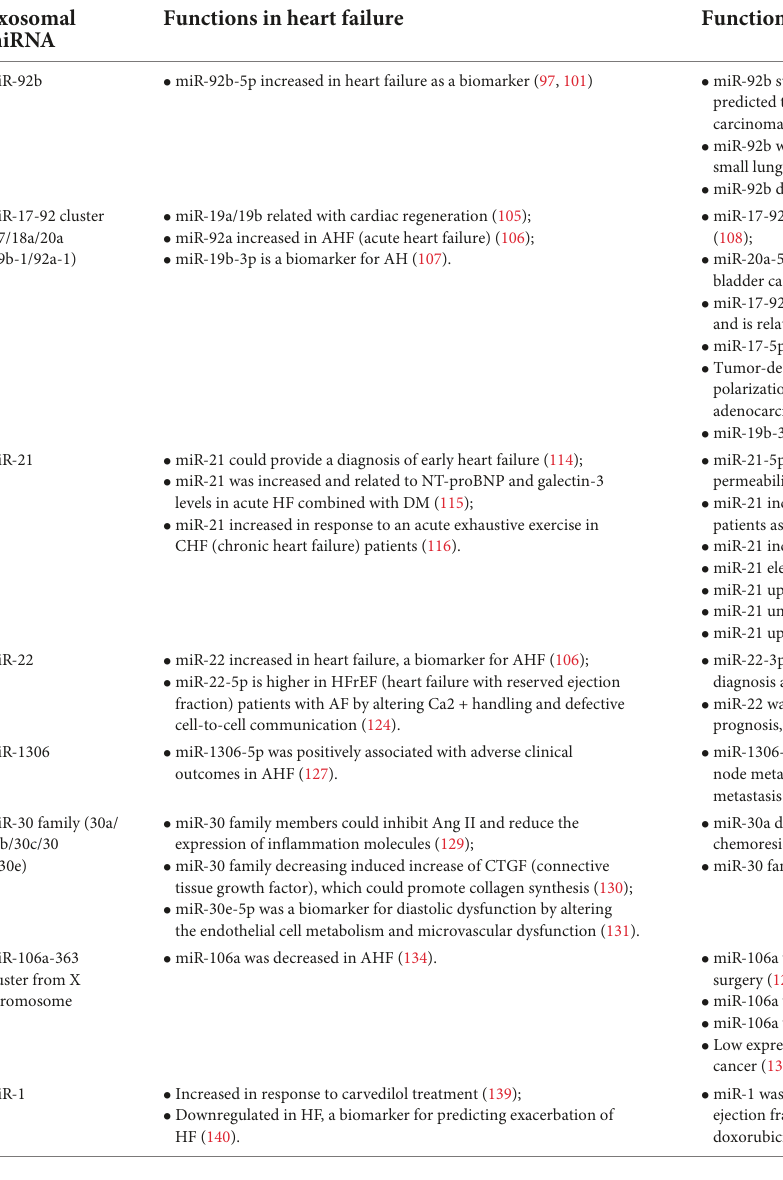
TABLE 1 Whole effects of circulation exosomal miRNAs for both heart failure and